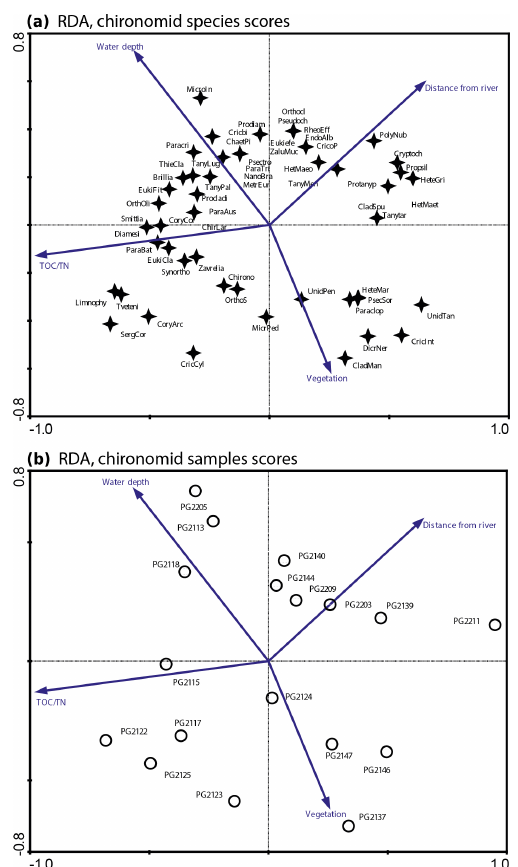
Figure 3. RDA biplots of chironomids in the surface sediments of Lake Bolshoe Toko. (a) Common chironomid taxa and significant environmental variables. (b) Chironomid sampling sites and